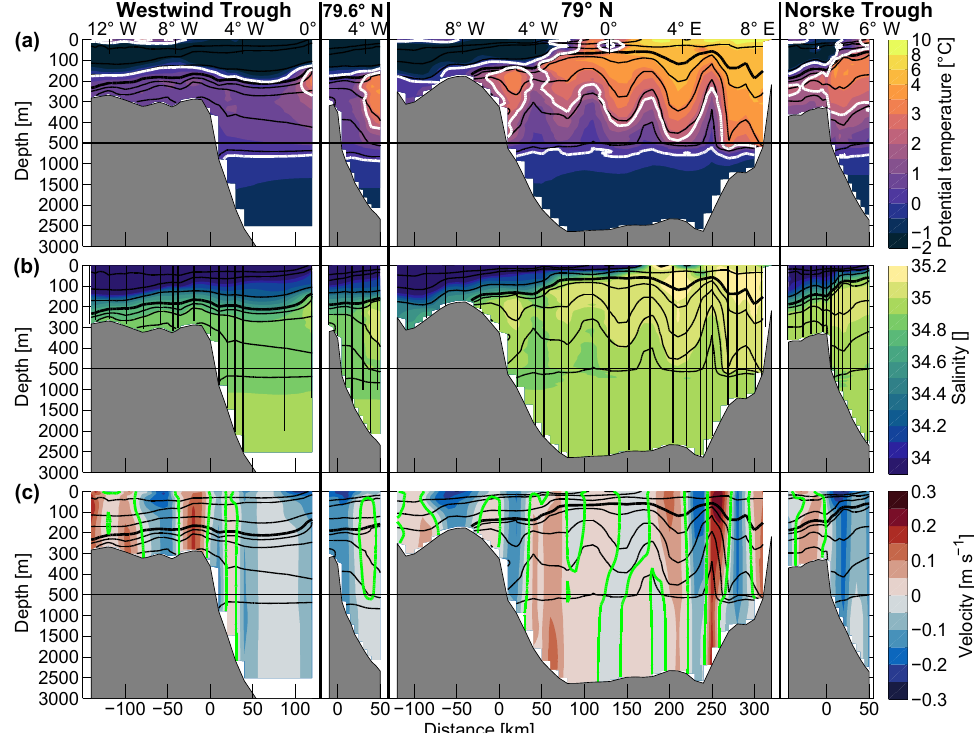
Figure 3. (a) Potential temperature, (b) salinity and (c) absolute geostrophic velocity for the sections crossing the east Greenland shelf break. Thin contours show potential density. The bold contour is the 27.8kgm − 3 isopycnal; above, the 26, 27 and 27.6kgm − 3 isopycnals are shown, and below the density levels increase in 0.05kgm − 3 steps up to 28kgm − 3 . Vertical black lines in (b) show station locations and depths. Please note the non-linear colour bars of salinity and temperature and that the y axis changes scale at 500m depth (black line). The white contours in (a) show the 2 and 0 ◦ C isotherms. The green contours in (c) show the 0ms − 1 isotach. Positive velocities are northward, negative velocities are southward. Section distance is 0km at the east Greenland shelf break. At 79 ◦ N there is a gap of 11 days between the stations east and west of 2 ◦ E. Casts to the east were sampled within 6 days, casts to the west were sampled within 4